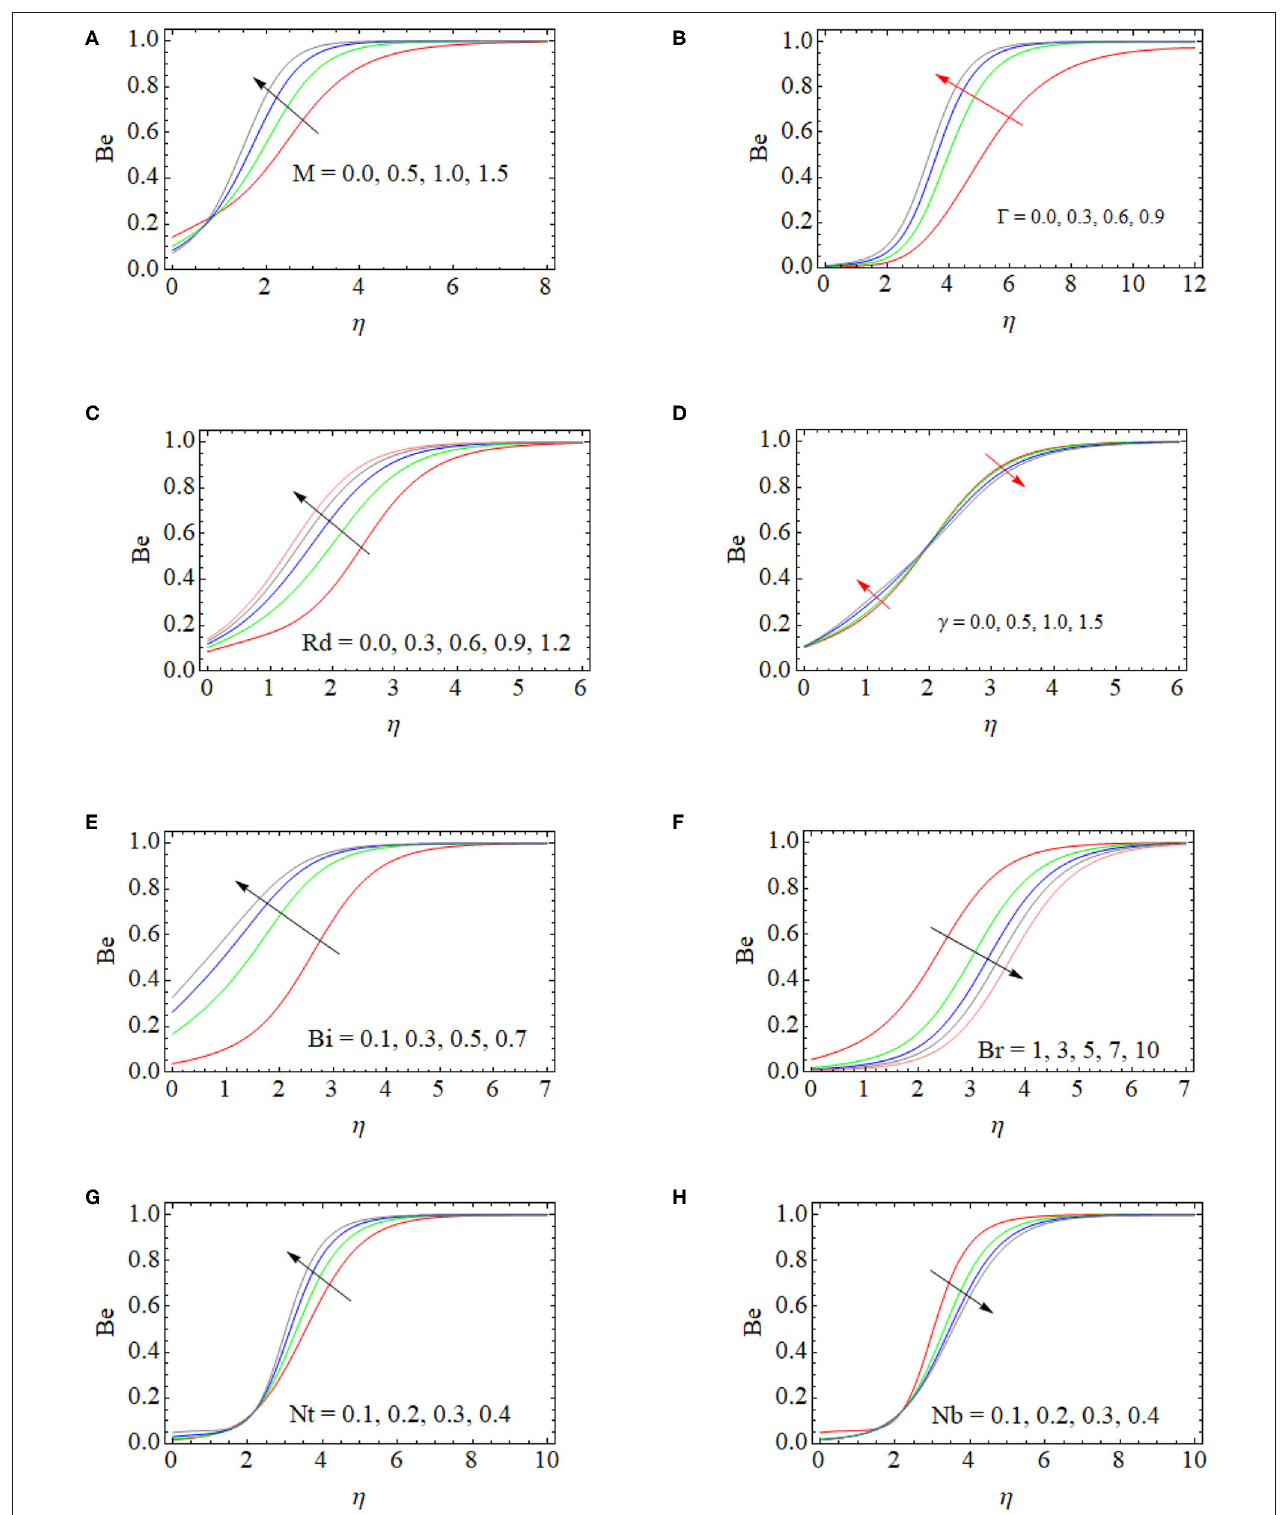
FIGURE 7 | (A–H) Impact of M , Ŵ , Rd , γ , Bi , Br , Nt , and Nb on the Bejan number B .